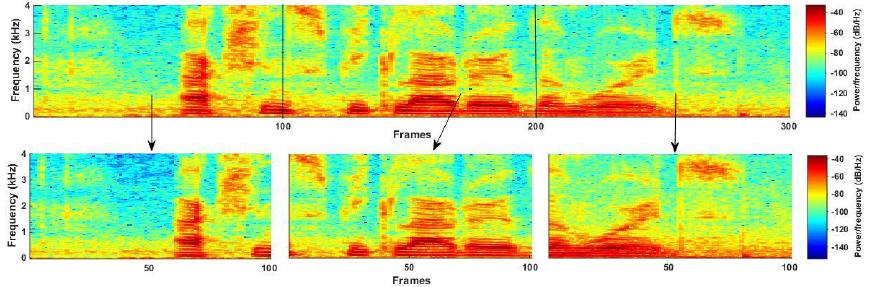
Figure 5. An illustration of the split method (b).